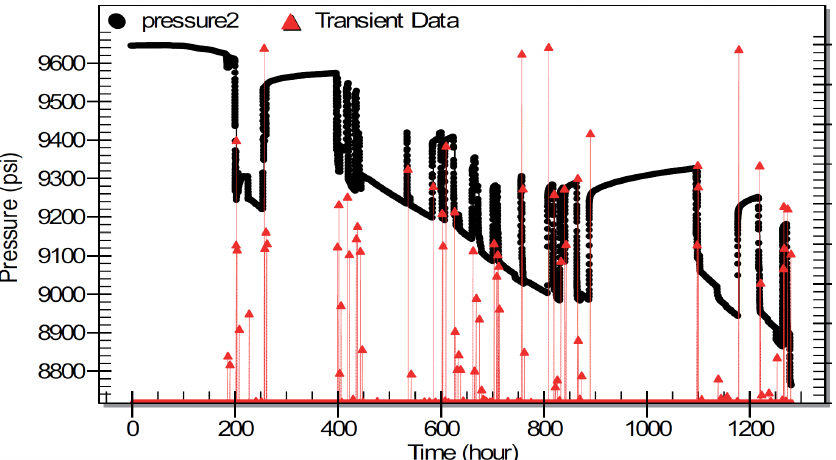
Figure 10. Detection result using the image pattern method from Olsen